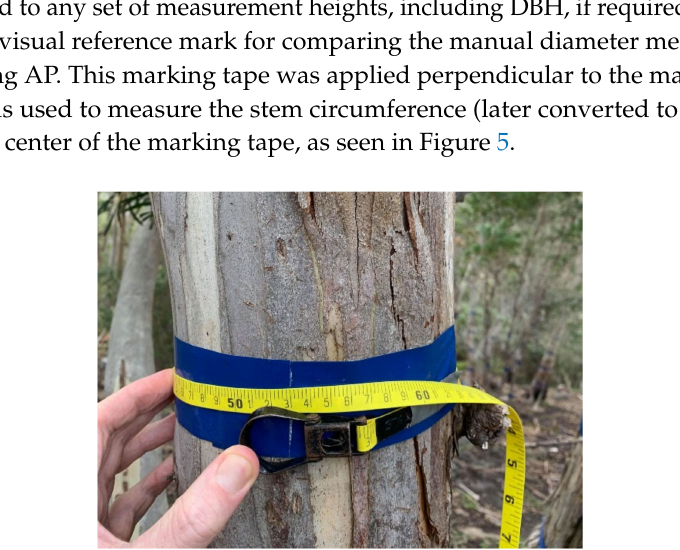
Figure 5. Manual field measurements of stem circumference were collected over blue marking tape such that both manual and photogrammetric point cloud-based measurements could be taken from the same location on the tree without influence of a digital terrain